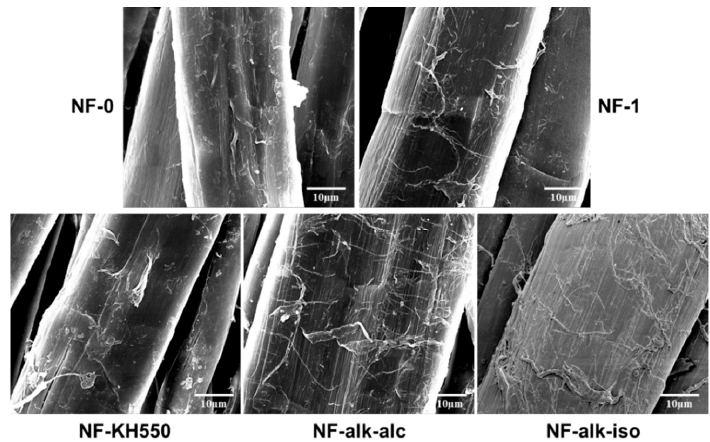
Figure 5. SEM imaging of di ff erent modified ramie fabrics.